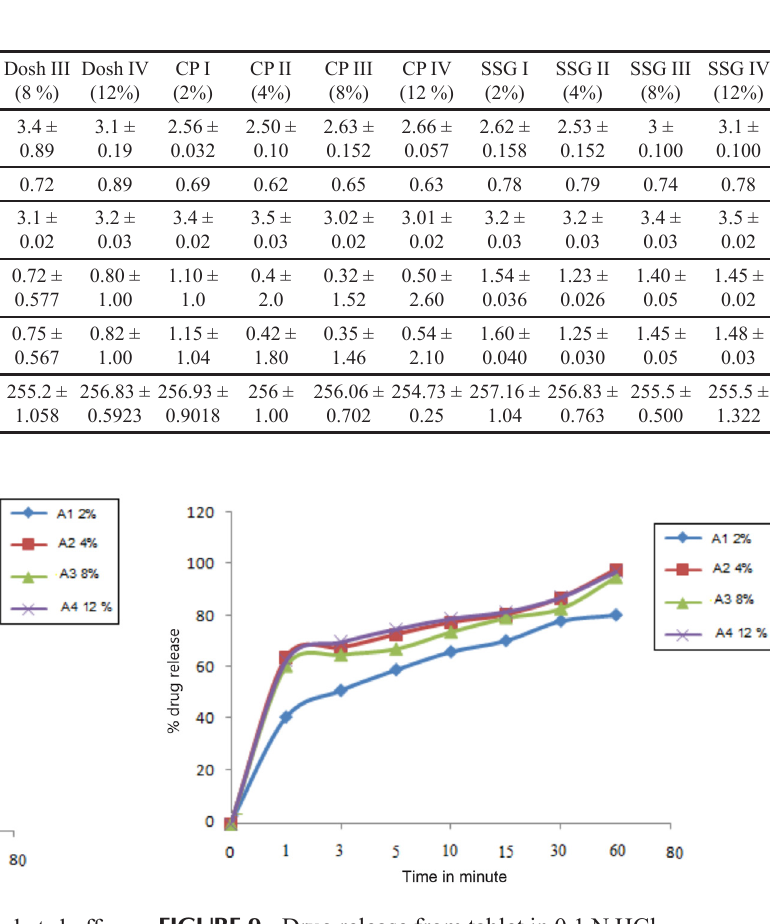
FIGURE 9 - Drug release from tablet in 0.1 N HCl. FIGURE 8 - Drug release from tablet in pH 6.8 phosphate buffer.